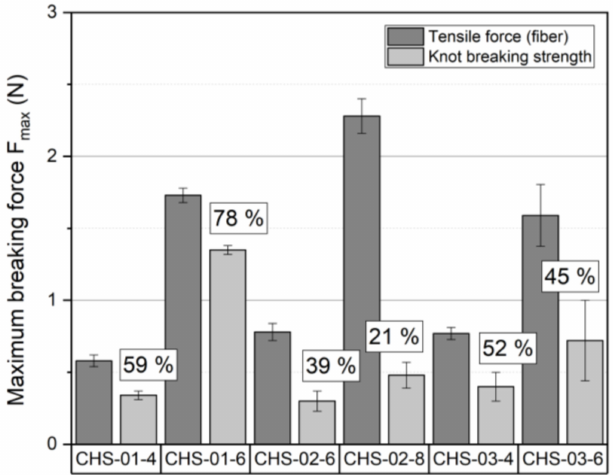
Figure 5. Comparison between the maximum tensile force and maximum knot breaking strength after a knot formation for the fibers from chitosan and ionic liquid BmimOAc with different solids content (knot breaking strength is additionally outlined with X% of the initial tensile